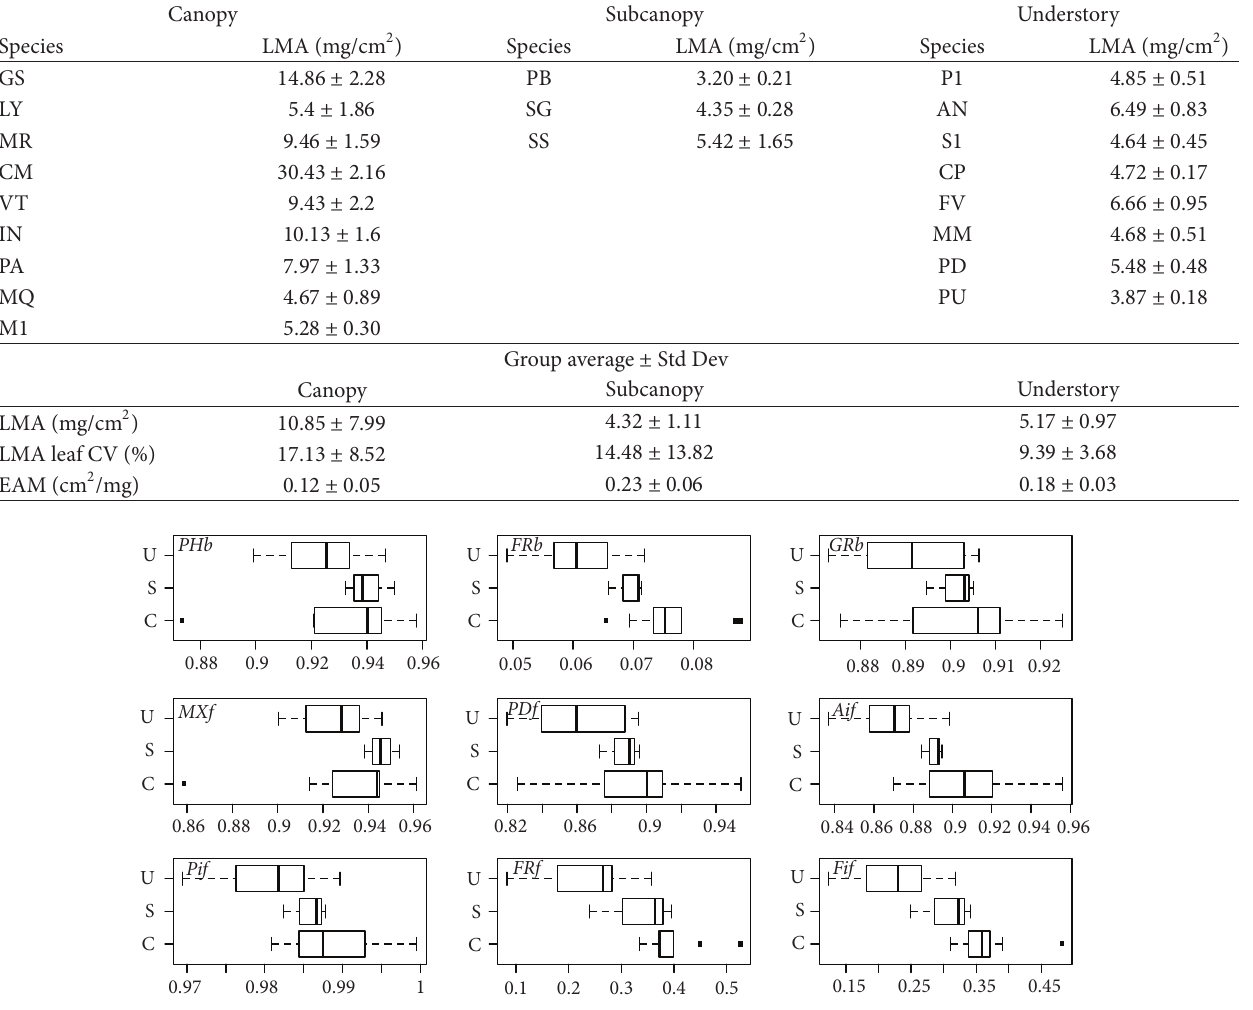
F 5: Leaf means of absorbance variables by group (canopy C, subcanopy S, and understory U).